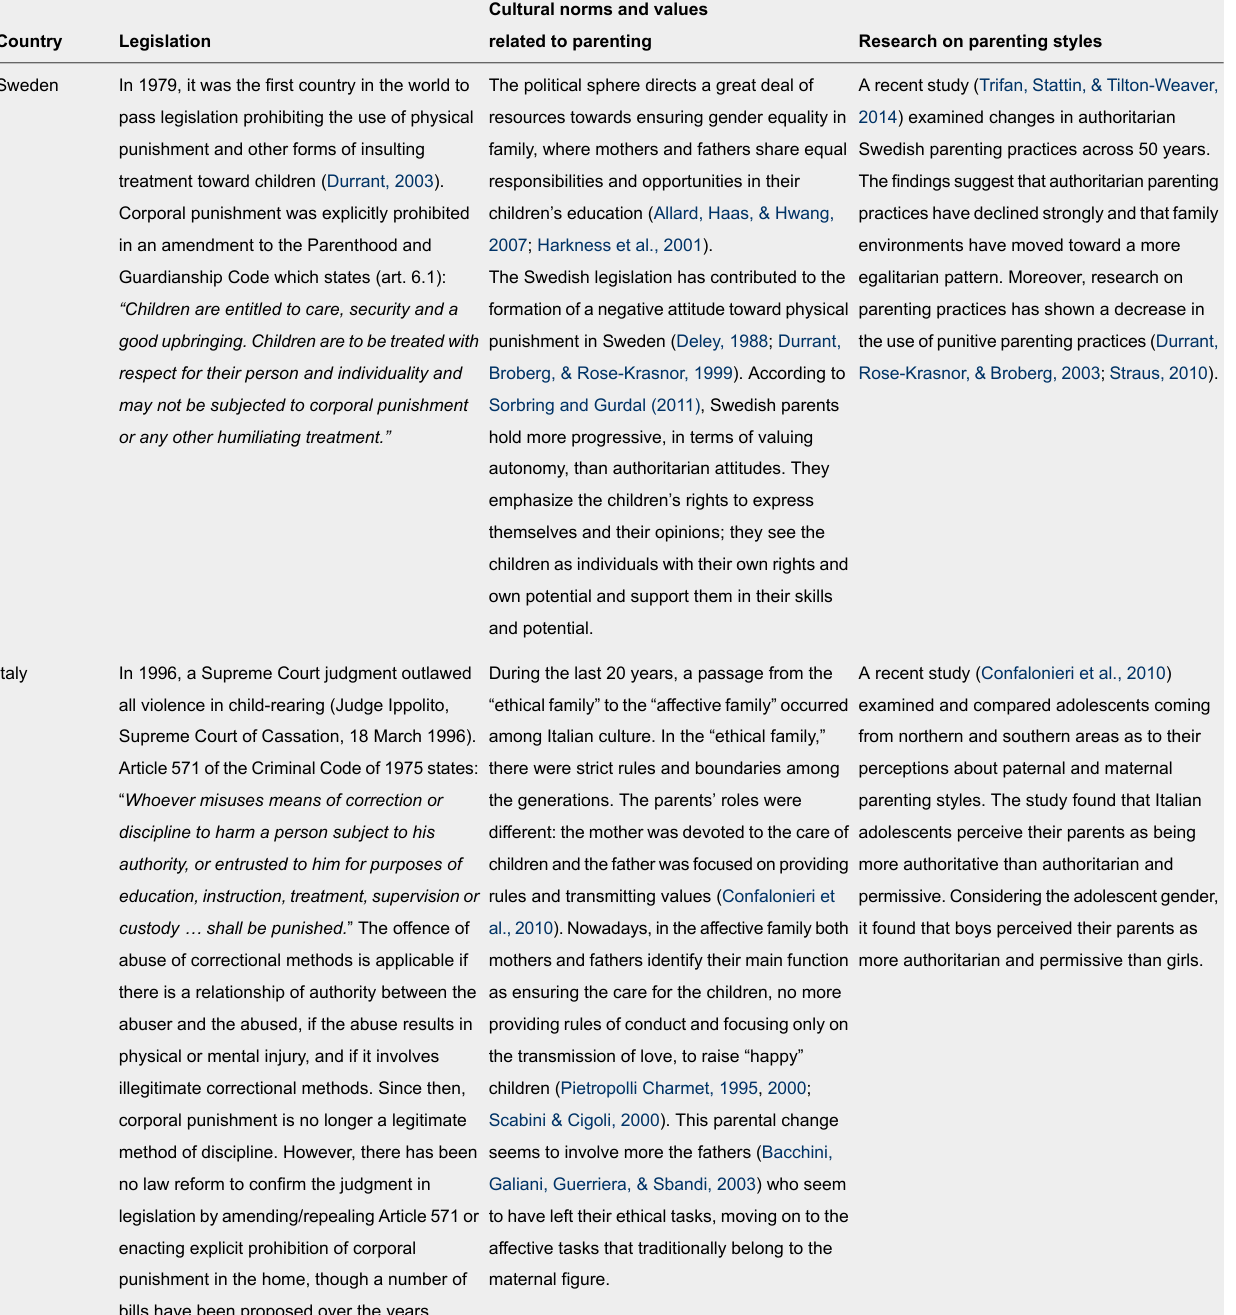
Legislation, Cultural Norms and Values Related to Parenting, and the Main Research Results on Parenting Styles in Sweden, Italy and